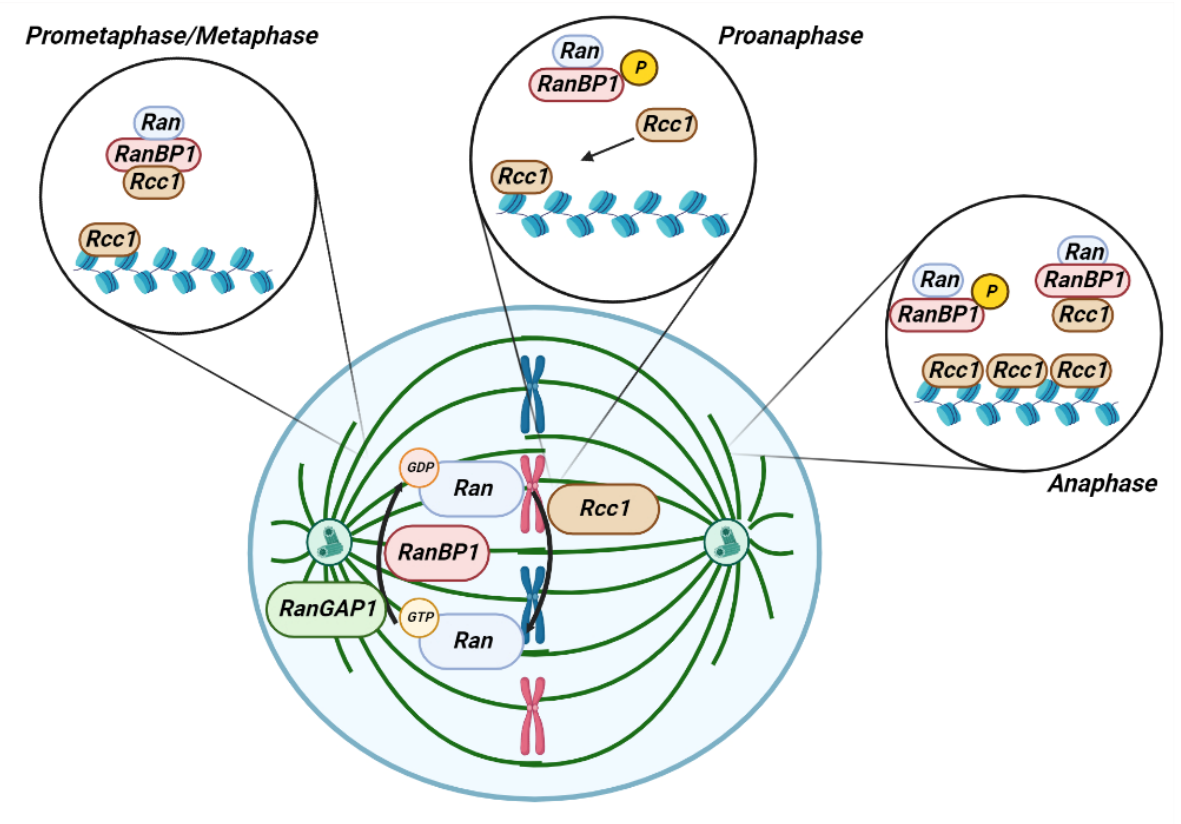
Figure 4. The RCC1/RAN/RANGAP1/RANBP1 ‐ axis in mitotic stability. Prometaphase: RCC1 fluctuates between an active state (chromatin bound pool) and an inactive state, bound to RANBP1 and nucleotide ‐ free ‐ RAN (RRR complex). Anaphase Onset: upon Ser 60 RANBP1 phosphorylation, RCC1 detachment from the RRR ‐ complex is realized. The free RCC1 is then engaged on chromatin. Anaphase: Increased chromatin ‐ bound RCC1 levels promote switch from Ran ‐ GDP to Ran ‐ GTP on chromatin. Interphase (not shown): nuclear envelope re ‐ formation physically splits RCC1 from RanBP1, thus preventing RRR complex assembly and RCC1 inhibition. Freely based from [42]